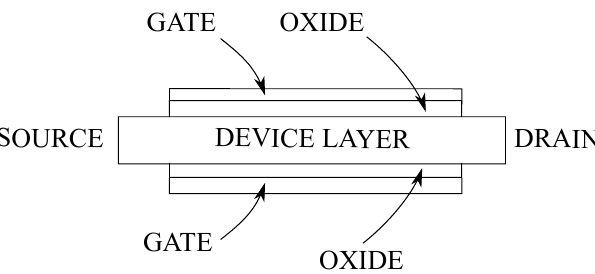
Figure 13. Cross-sectional view of a double gate junctionless